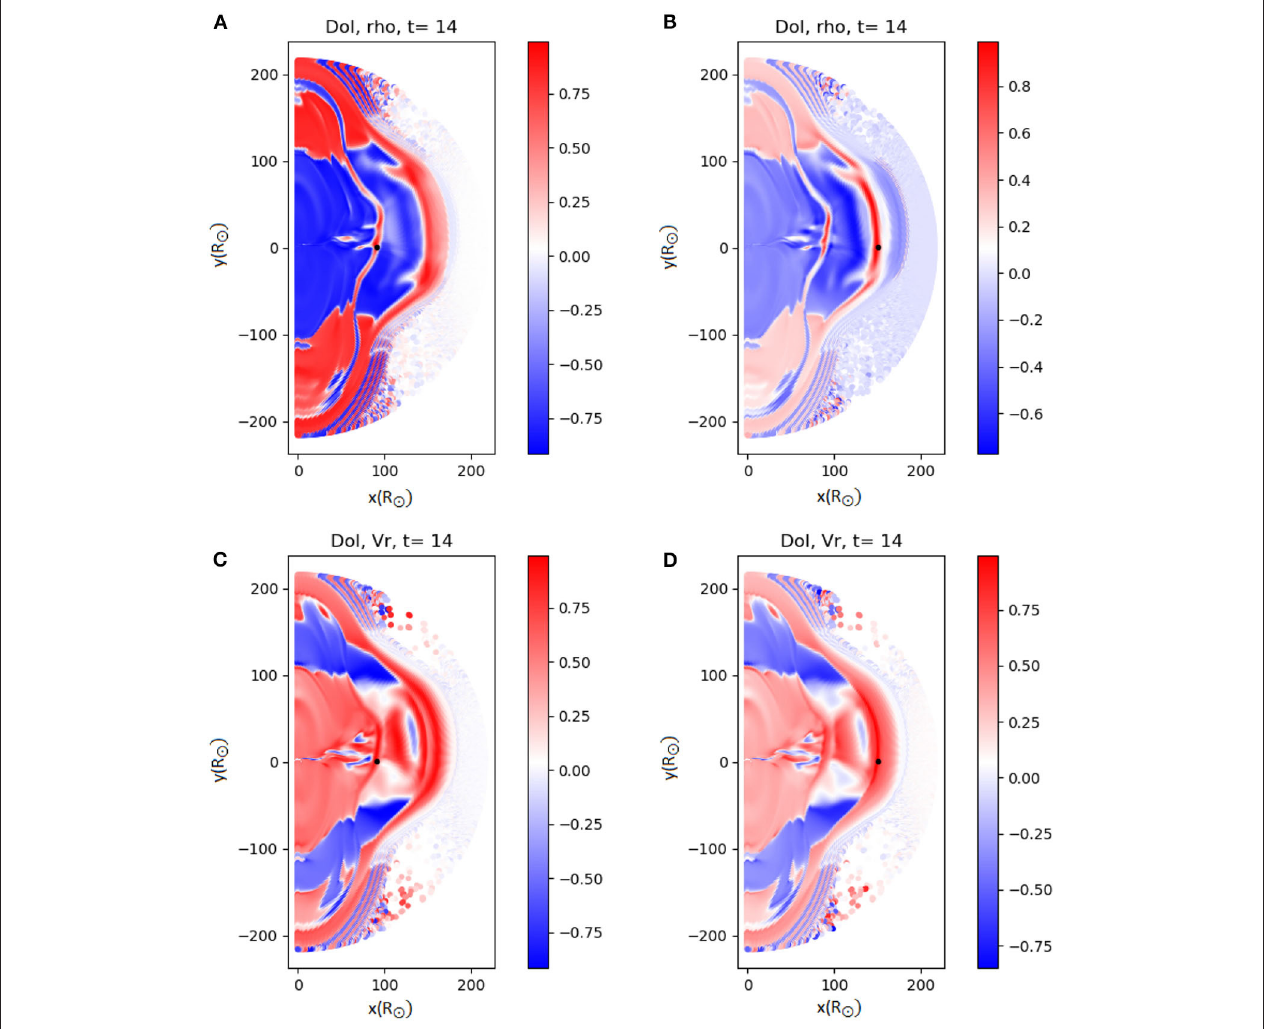
FIGURE 13 | DOI maps from ensembles of PLUTO simulations for the density (A,B) and the radial velocity (C,D) . The first column has a detection point at R = 90 R ⊙ and the second column at R = 150 R ⊙ . In this set we perturb two parameters, the radial velocity and the size of the CME, with a larger perturbation in the size with respect to the second data